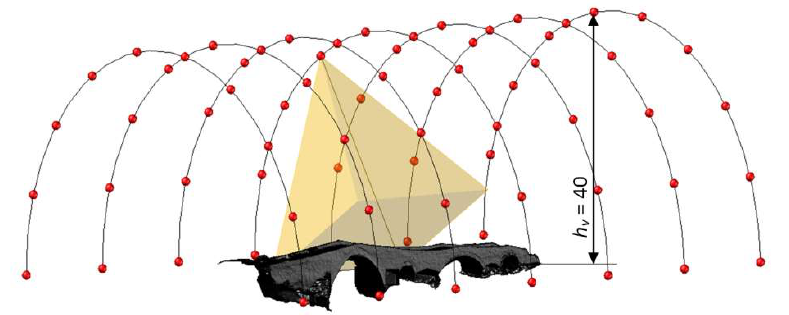
Figure 8. Waypoint in CG at h v = 40 m. Table 3. (a) GSD , overlaps, and pitches in RGVC; (b) GSD , overlaps, and pitches in RGOC; (c) GSD , overlaps, and pitches in EG; (d) GSD , overlaps, and pitches in CG. (a) Table 4. Geometric characteristics of: RGVC, RGOC, EG, and CG. RGVC—Rectangular Grid with Vertical Camera